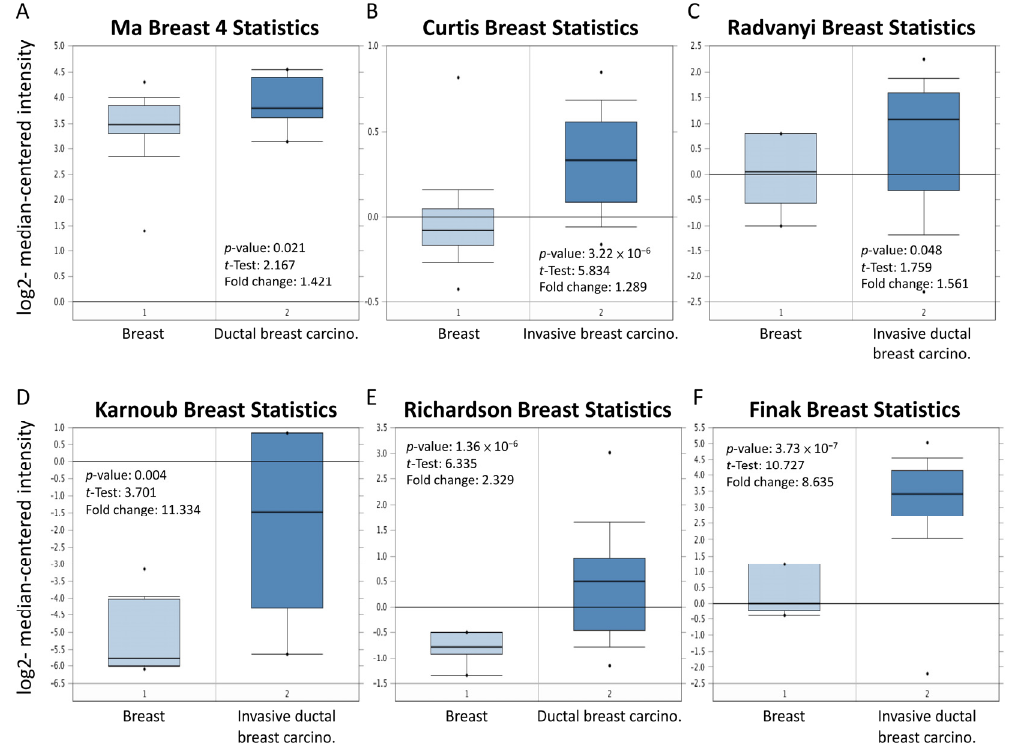
Figure 4. Box and whiskers plots of Oncomine data on MARCH5 . MARCH5 mRNA levels from ( A ) Ma Breast 4 statistics cohort, ( B ) Curtis Breast Statistics cohort, ( C ) Radvanyi Breast Statistics cohort, ( D ) Karnoub Breast Statistics cohort, ( E ) Richardson Breast Statistics cohort, and ( F ) Finak Breast Statistics cohort in BRCA and normal tissue. Note: p < 0.05 indicates statistical significance; MARCH5 was among the top 1% overexpressed genes in all six different datasets of BRCA.